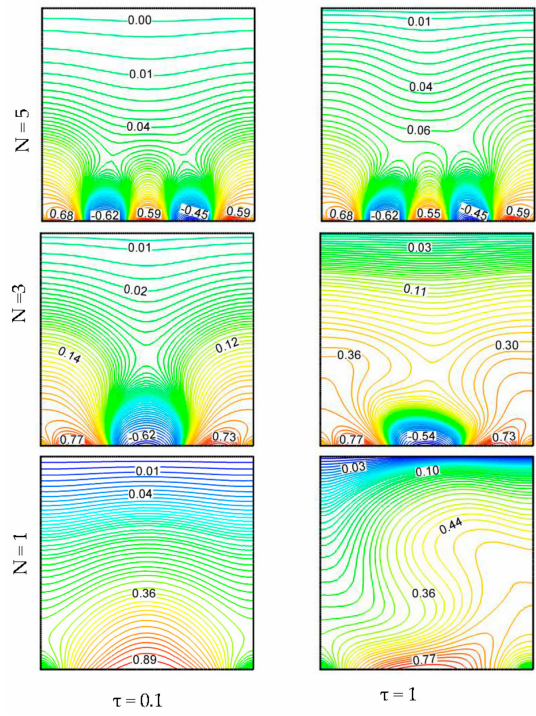
Figure 13. Influence of the odd values of N on isotherms for the selected values of τ with Gr = 10 7 .